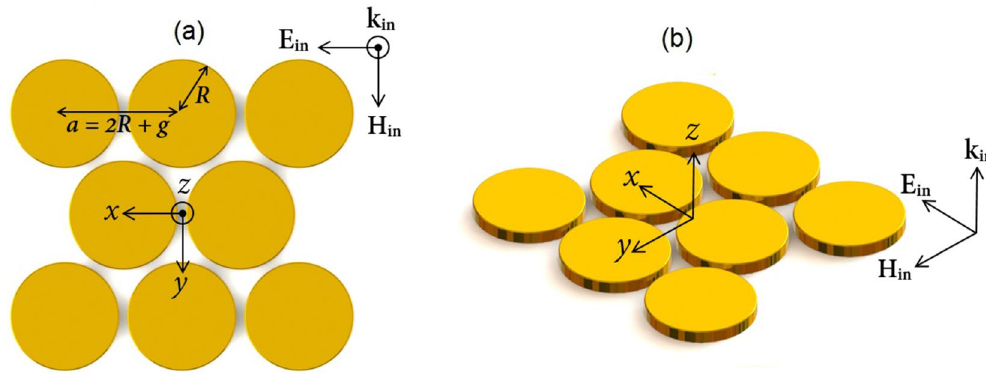
Figure 1. Schematic diagram of our proposed oligomer supporting the double-Fano spectral line profile ( a ) 2D and ( b ) 3D views. The structure is a finite triangular lattice of free-standing disk-shaped gold nanoparticles with lattice constant a = 180 nm , where all the particles have the radius R = 84 nm , height h = 20nm , and gap distance of g = 12nm . This oligomer is illuminated by an x -polarized plane wave propagating along the z -direction. The electric field is parallel to the axis of the central dimer, denoted as the parallel